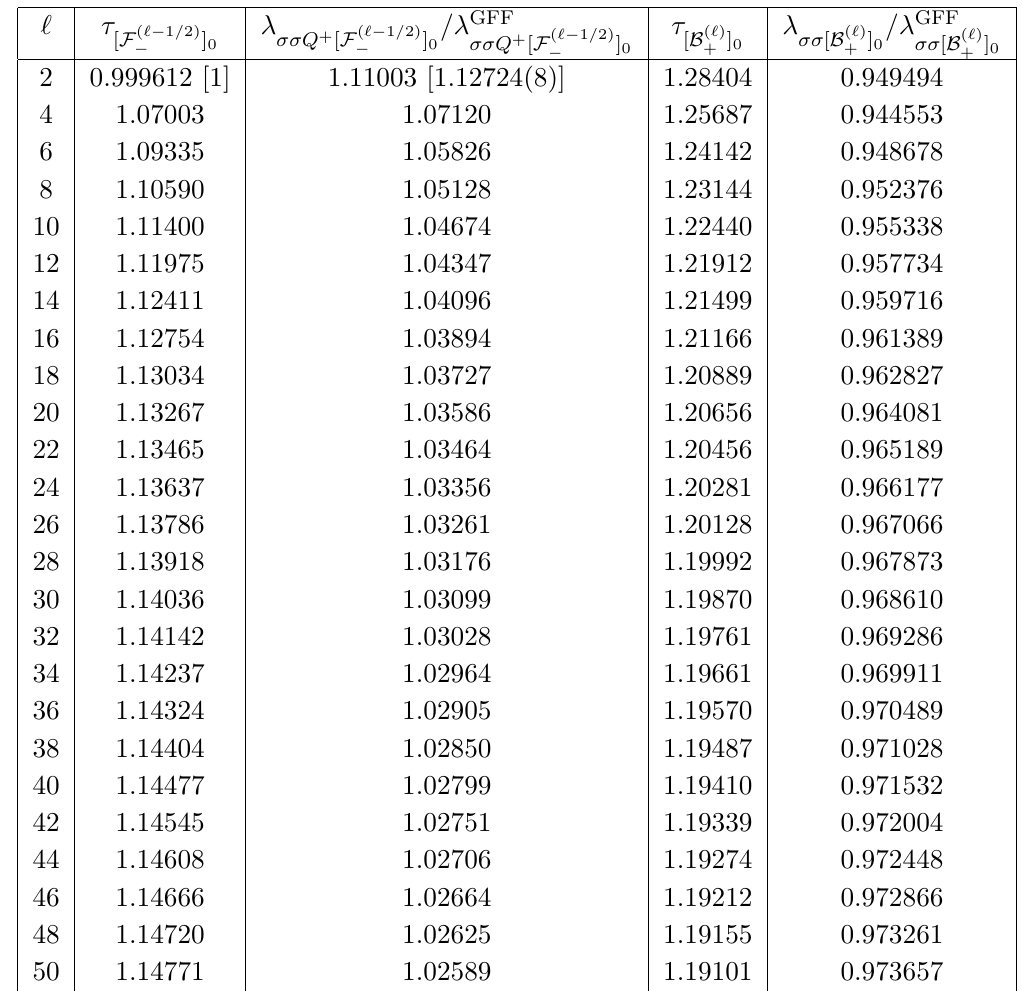
Table 1 . CFT data for the leading F ( ‘ − 1 / 2) and B ( ‘ ) trajectories in the N = 1 super-Ising + − model computed using the Lorentzian inversion formula. This data corresponds to the LI z = . 05 : { 1 , σ, (cid:15), [ σσ ] ‘ 0 =100 , [ σ(cid:15) ] ‘ 0 =100 } computation shown in figures 4 and 5. Rigorous determinations for 2 − 98 0 − 99 the stress-tensor data are shown in square